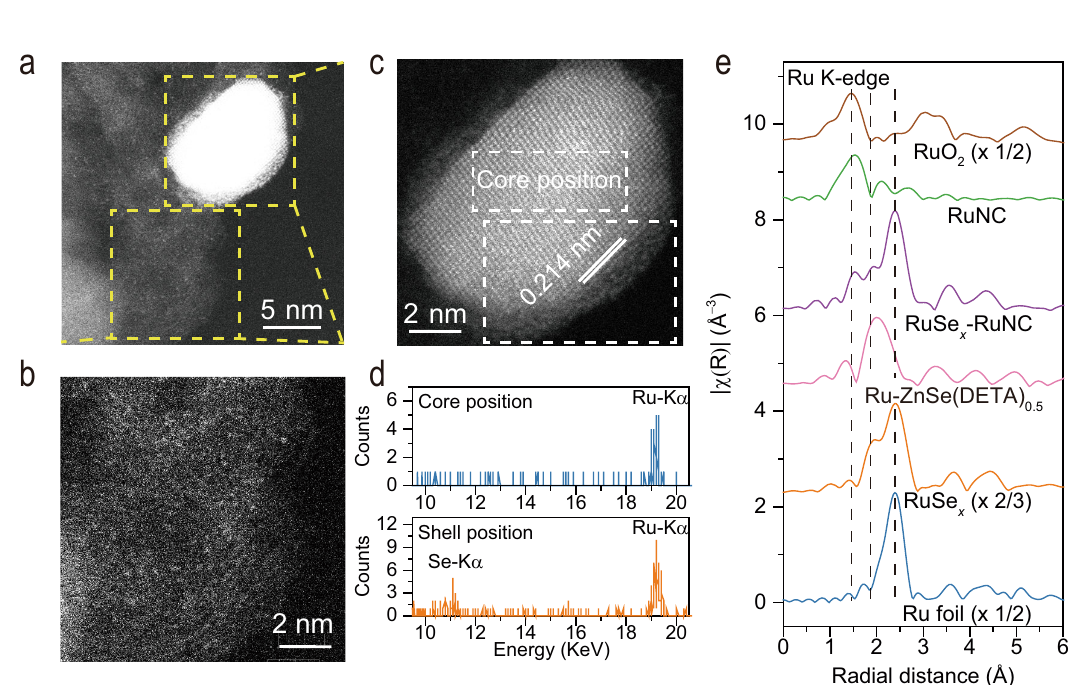
Fig. 3 | Fine structure characterization. a – c The sub-Å resolution HAADF-STEM images of RuSe x and surrounding RuNC. d The element analysis by sub-Å resolution HAADF-STEM-EDX. e The k 2 -weighted FT spectra of Ru K -edge